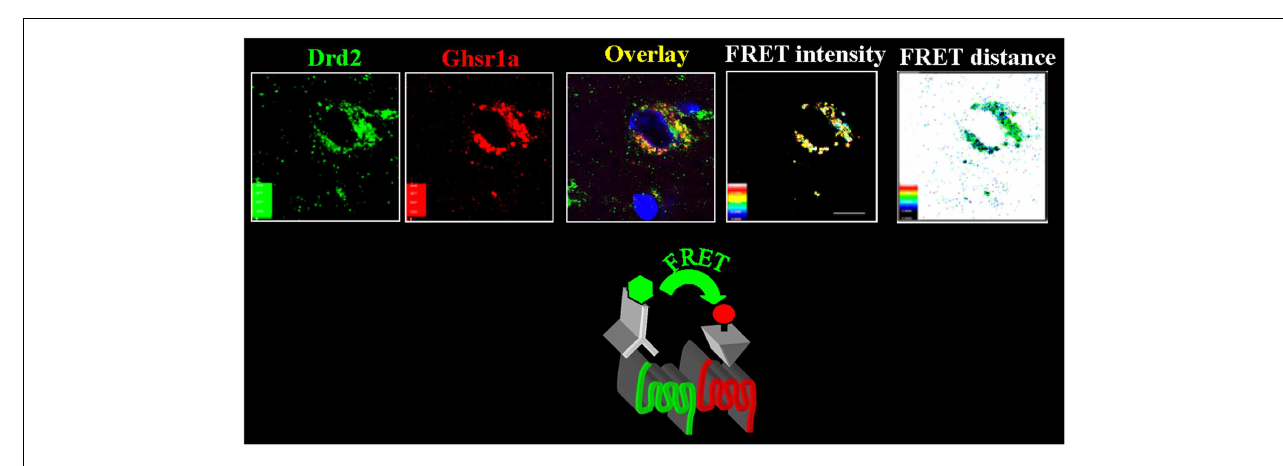
GHSR1a [identified using red fluorescent ghrelin (Cy5)] and DRD2 [in green, identified by immunofluorescent DRD2 monoclonal antibody (Cy3)] are in close proximity at a distance of 5–6nm and FRET intensity 0.4–0.6